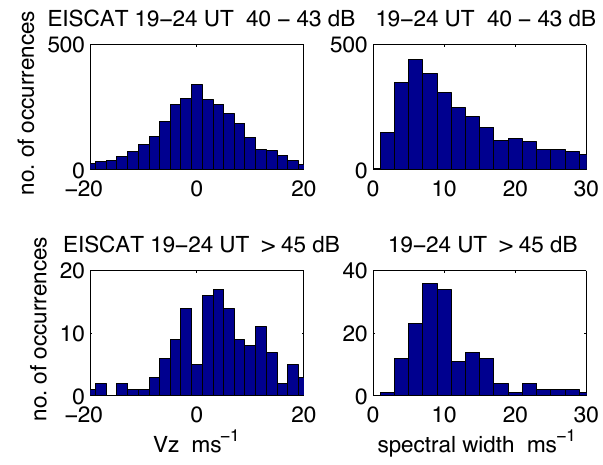
Fig. 7. Histograms showing the distribution of Doppler shifts and spectral widths for the EISCAT observations included in Fig. 5. The power interval 40–43dB is chosen to represent echoes from the background ionospheric plasma, while power > 45dB is repre- sentative of